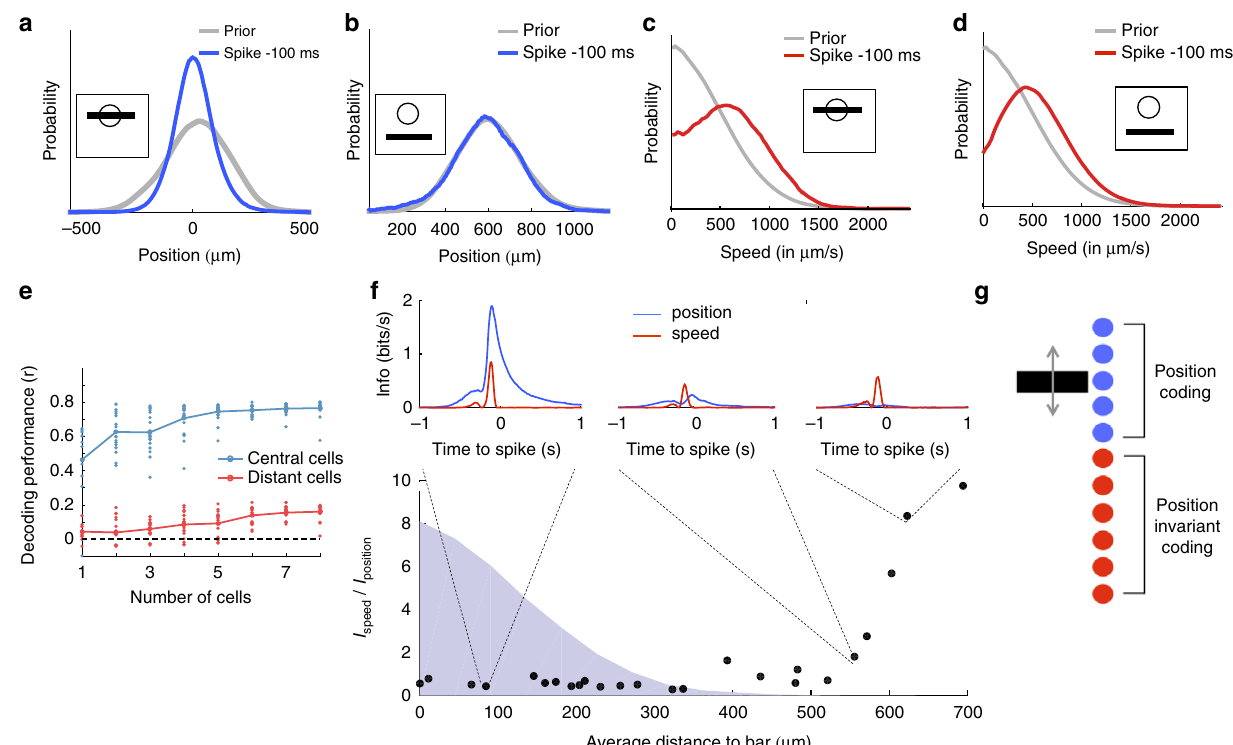
Fig. 6 Central computation codes for position, while distant computation is invariant to position and codes for stimulus change. a Distribution of the bar positions for the complete stimulus trajectory ( “ prior distribution ” , gray) and 100 ms before the spike of a central cell (blue). Zero corresponds to the location of the cell ’ s receptive fi eld (RF) center. b Same as A for a distant cell with its receptive fi eld center far from the bar. c Distribution of the absolute speed of the bar for the complete stimulus trajectory (gray) and 100 ms before the spike of a central cell (red). d Same as c for a distant cell (red). e Decoding performance of the position of the bar using linear decoding, against number of cells, for either central cells (blue) or distant cells (red). Each point corresponds to one subset of cells, and the curves correspond to the average performance. f Ratio between the information individual cells carry about bar speed vs about bar position, as a function of the average distance to the bar. Distribution of bar positions is shown as a blue shade. For selected cells, the insets indicate the mutual information between the spiking response and the position (blue) or the speed (red) at different time delays. g Schematic showing that central cells code for bar position while distant cells are nearly invariant to